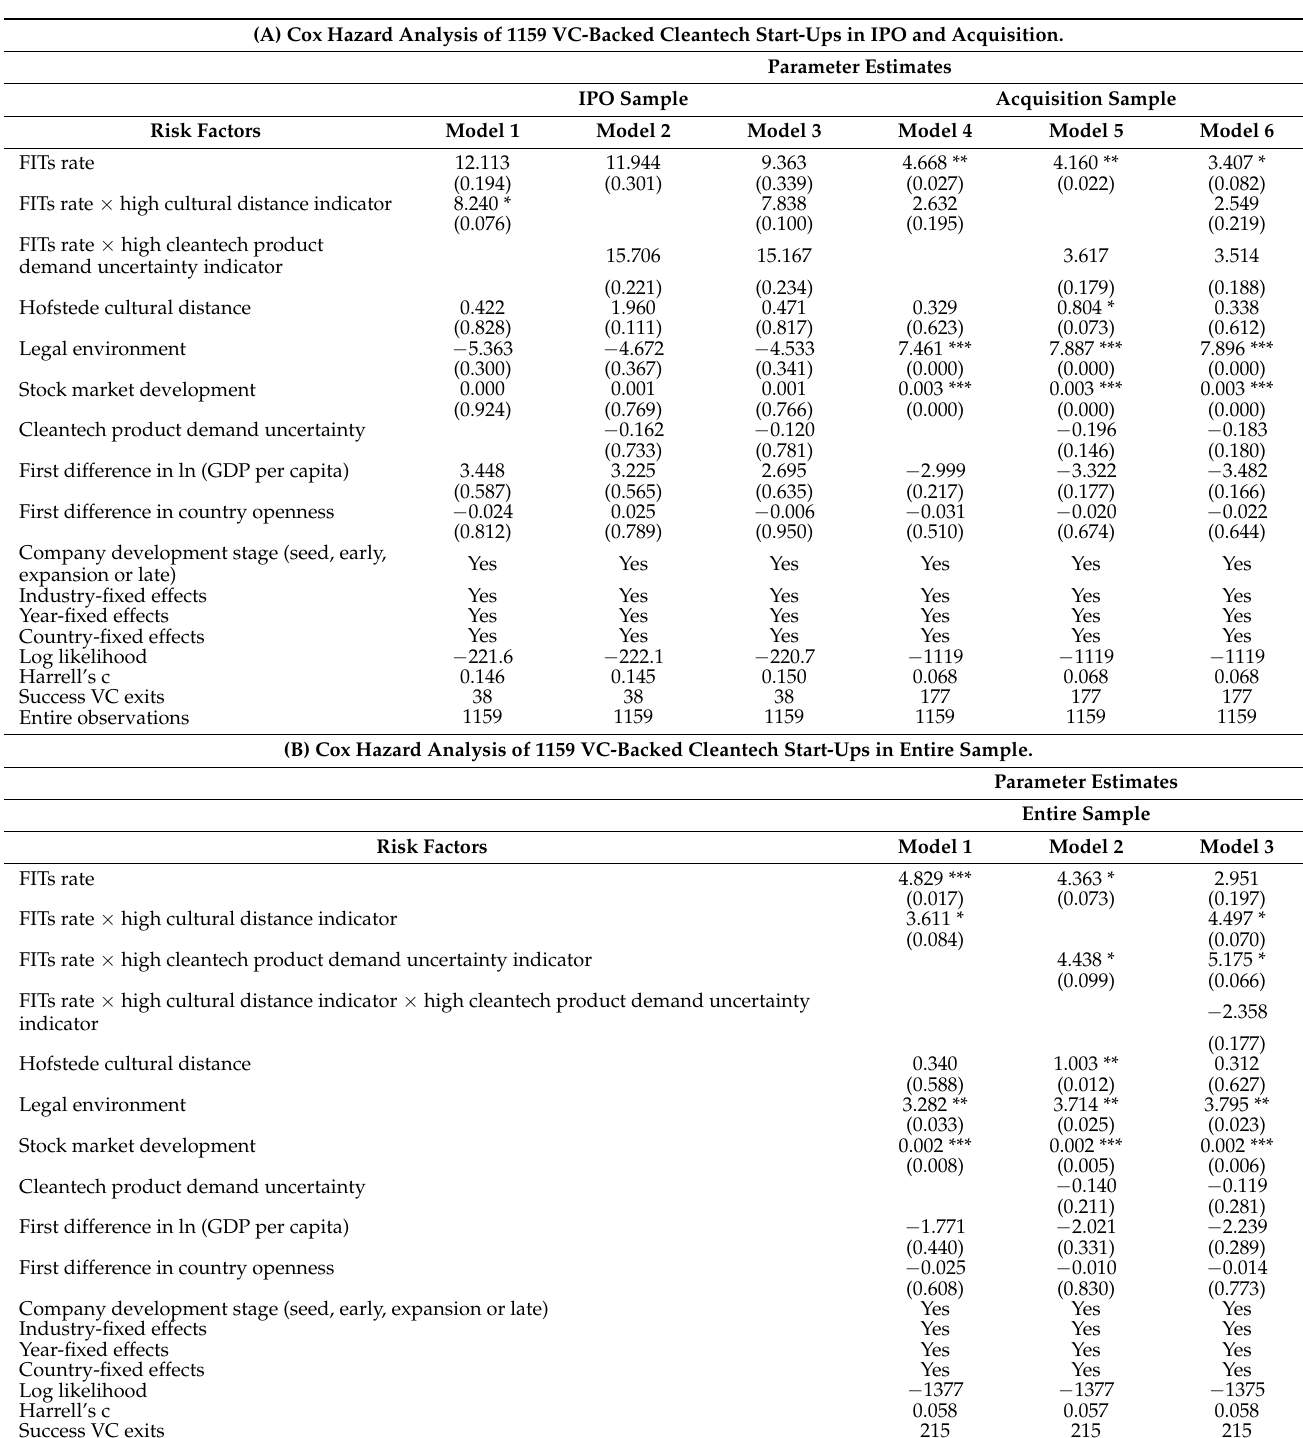
Table 6. Cox hazard analysis of 1159 VC-backed cleantech